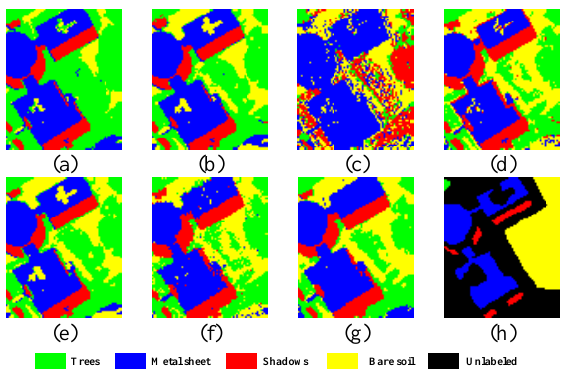
Figure 2. Clustering results on the University of Pavia image: (a) CFSFDP, (b) FCM_S1, (C) SSC, (d) S 4 C, (e) KSSC, (f) SSC-SMP, (g) KSSC-SMP, (h) ground